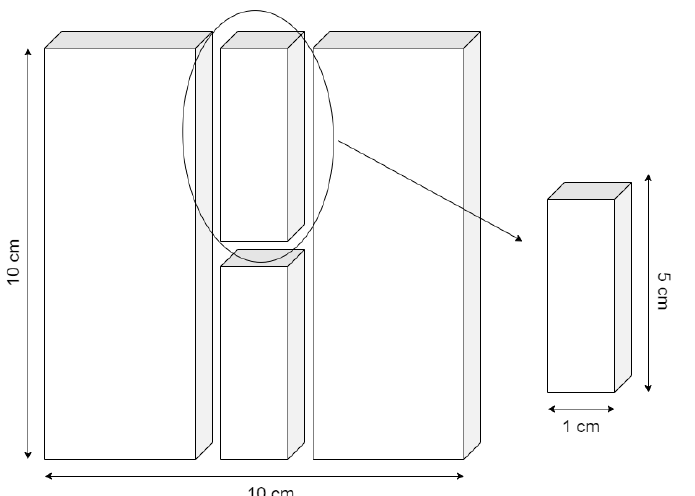
Figure 2. Scheme of sample cutting.